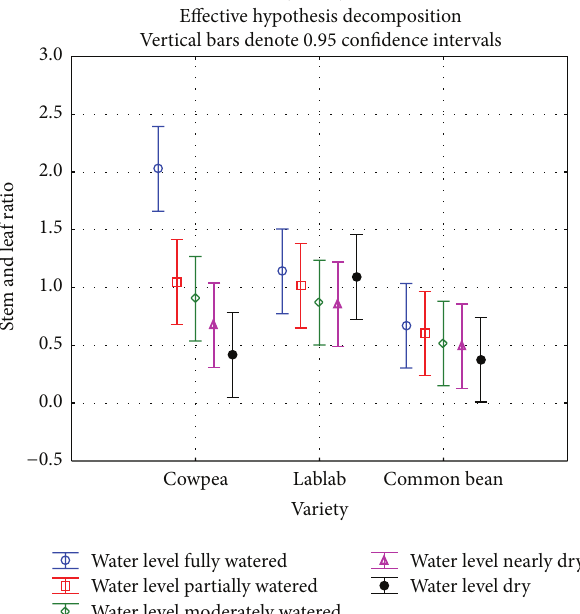
Figure 19: Transpiration on 58 DAP.